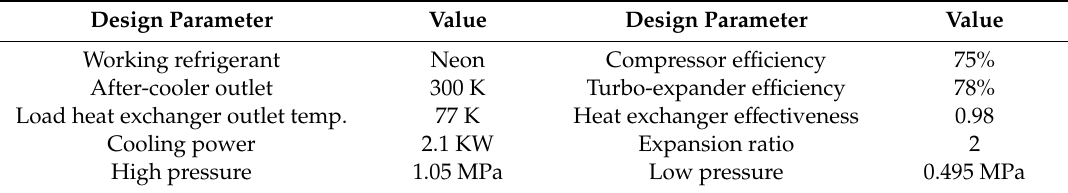
Table 1. Design parameters of the reverse Brayton cryogenic system. Design Parameter Value Working refrigerant After-cooler outlet Load heat exchanger outlet temp.